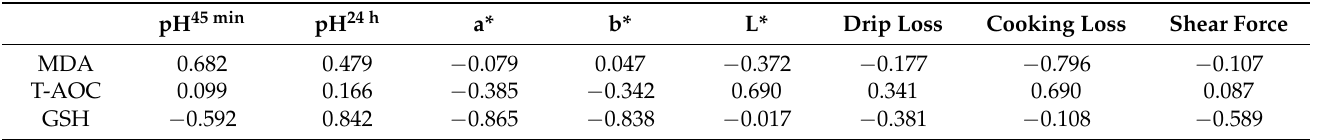
Table 7. Correlation coefficients between the meat quality and antioxidant capacity of slow-growing chickens on day